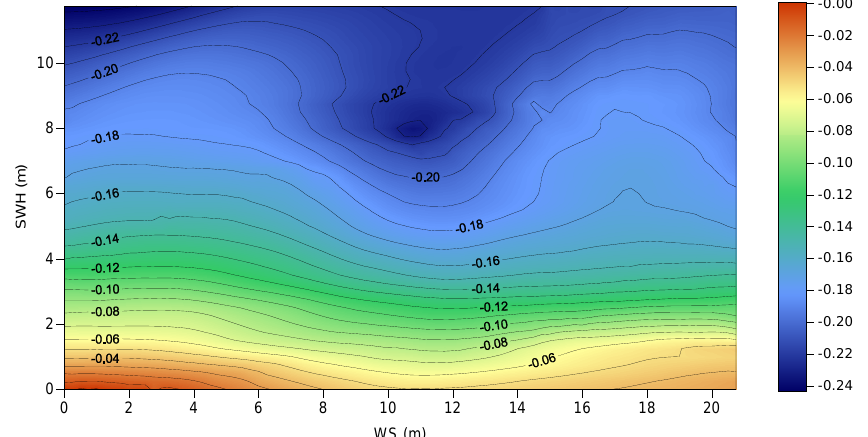
Figure 12a – Labroue SSB model for TOPEX B (metres).